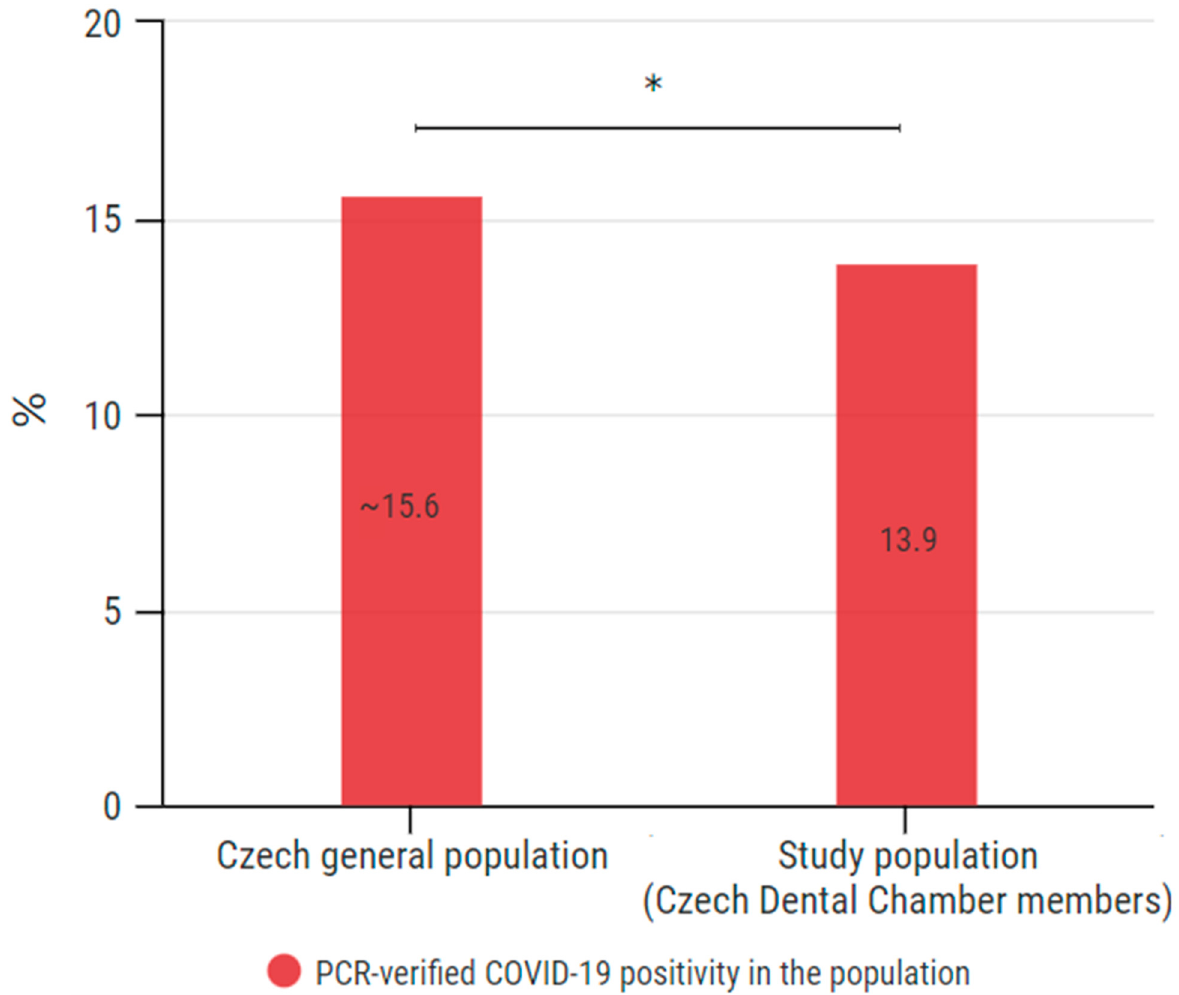
Figure 9. Comparison of COVID-19 prevalence in the Czech general population and its estimation within the population of Czech Dental Chamber members. Chi-square with test Yates’s correction was used for statistical analysis; p = 0.0180. * indicates p < 0.05